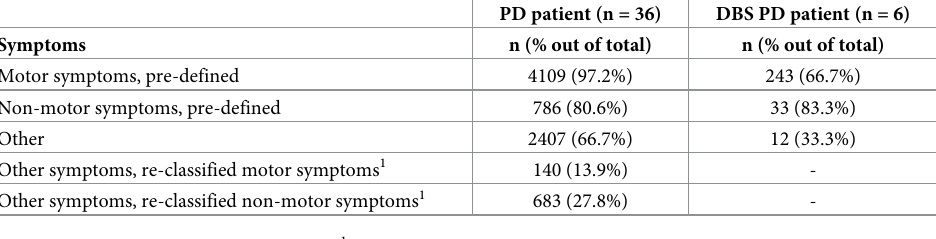
Table 3. Event counts of PD symptoms reported in the mobile application and the relative amount of the subjects who had reported that symptom type at least